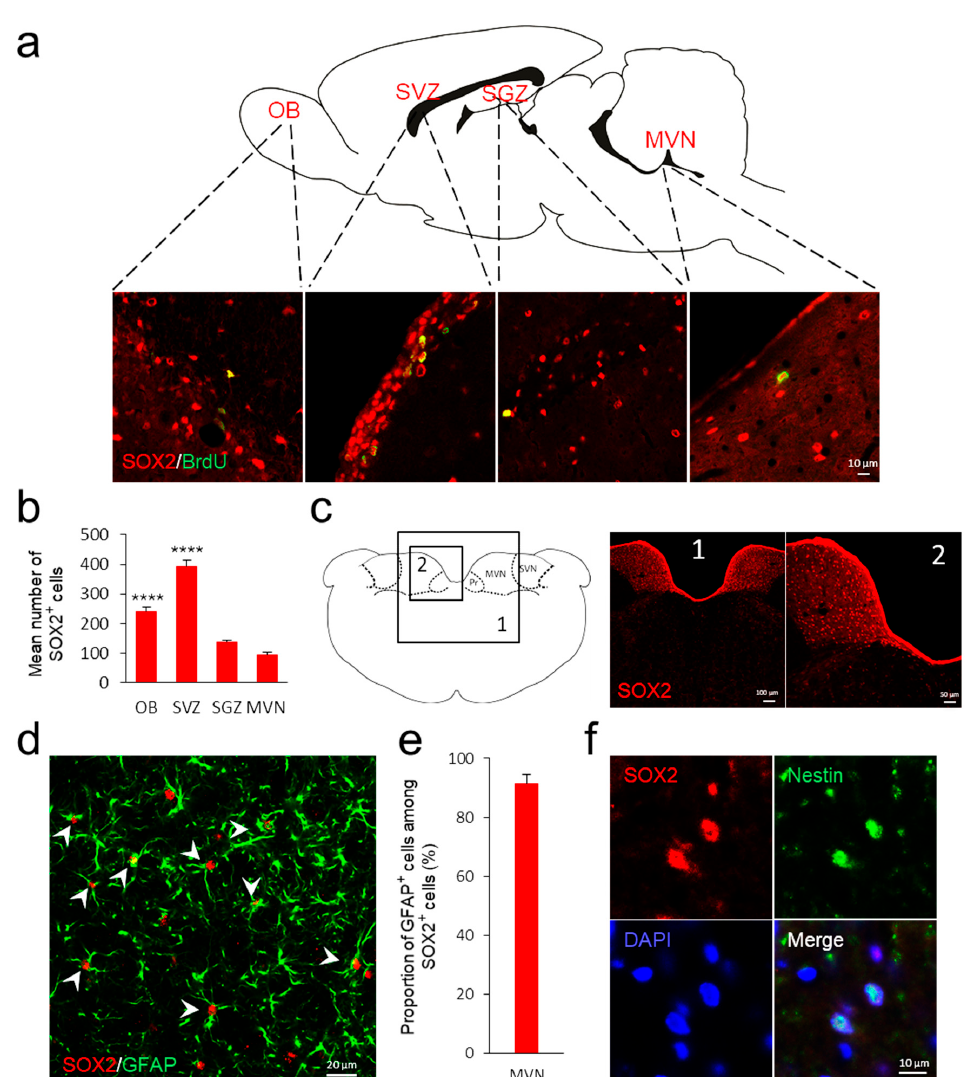
Figure 1. Neural stem cells in classical niches and in the vestibular nuclei of adult rats . ( a ) Schematic drawing of adult neurogenic niches of the rodent brain (OB: olfactory bulb, SVZ: subventricular zone, SGZ: subgranular zone, MVN medial vestibular nucleus). Lower part: confocal immunostaining images of newly generated (BrdU+, in green) and SOX2+ (in red) cells in coronal sections of OB, SVZ, SGZ and MVN of adult control rats. Scale bar, 10 µ M. ( b ) Histograms comparing the number of SOX2+ cells in the OB, SVZ, SGZ and MVN of adult control rats. Error bars represent SEM. Statistical analysis were made only with the MVN. **** p < 0.0001. ( c ) SOX2+ cells in the vestibular nuclei. Left panel: schematic representation of a coronal section of the rat brainstem at the level of the vestibular nuclei. Right panel: presence of SOX2+ cells in the brainstem of an adult rat at the Interaural − 2.64 mm and Bregma 11.64 mm level of the Paxinos and Watson stereotactic atlas. Scale applies to panel 1: 100 µ M; panel 2: 50 µ M. MVN = medial vestibular nucleus; SVN = superior vestibular nucleus; Pr = prepositus nucleus. ( d ) Merged representative image of MVN from adult control rats immunostained with SOX2 (red) and GFAP (green) antibody to identify neural stem cells. Arrowheads represent cells colocalizing SOX2 and GFAP marker. Scale bar, 20 µ M. ( e ) Percentage of SOX2+ cells that colocalized with GFAP marker. ( f ) Representative MVN image from adult control rats stained with antibodies against SOX2, Nestin and DAPI to identify neural stem cells. Scale bar, 10 µ